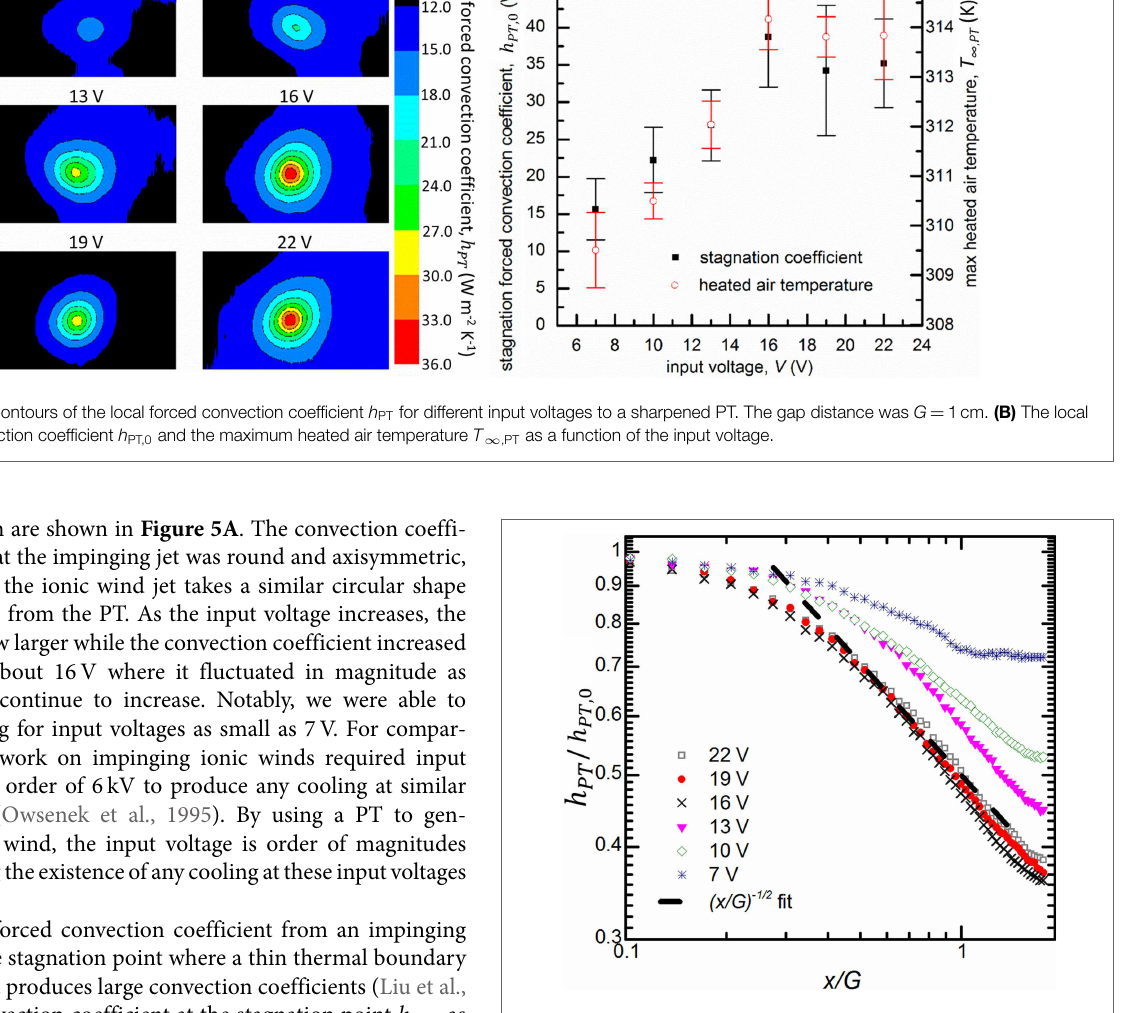
The value of the stagnation convection coefficient was